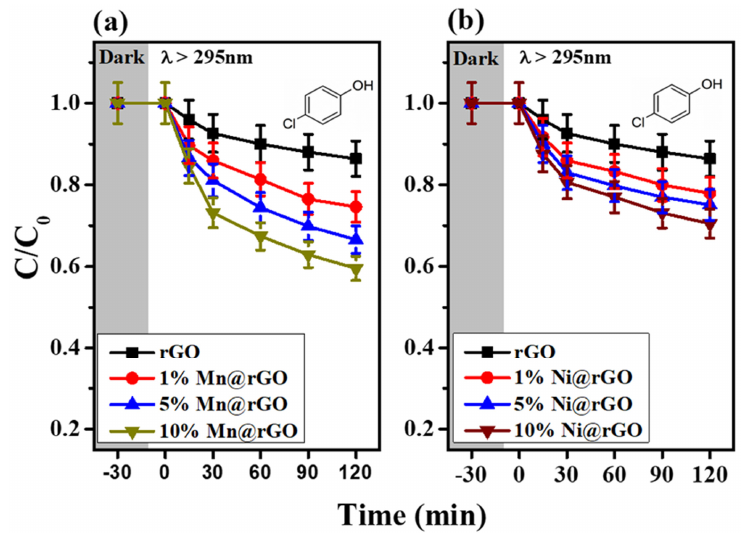
Figure 3. PCD of 4 ‐ CP using ( a ) Mn@rGO and ( b ) Ni@rGO with different dopant ion concentrations. [rGO] = 0.5 g/L, λ ≥ 295 nm, [4 ‐ CP] 0 = 10 μ M. Table 2. PCD efficiencies, 4 ‐ CP (C/C0) of three rGO samples with to 4 ‐ CP (degradation time of 2 h). rGO Doping amount Mn@rGO Ni@rGO 0.844 ± 0.05 TM ion 1% 0.746 ± 0.05 0.779 ± 0.05 ‐ 0.705 ± 0.05